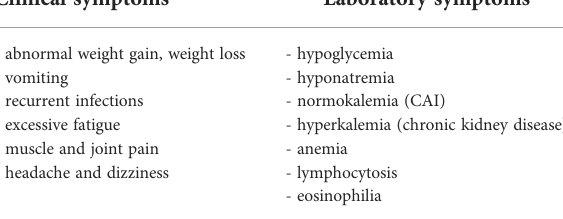
TABLE 3 Symptoms of adrenal insuf fi ciency in children which indicate the need for the early assessment of hypothalamic-pituitary-adrenal axis function